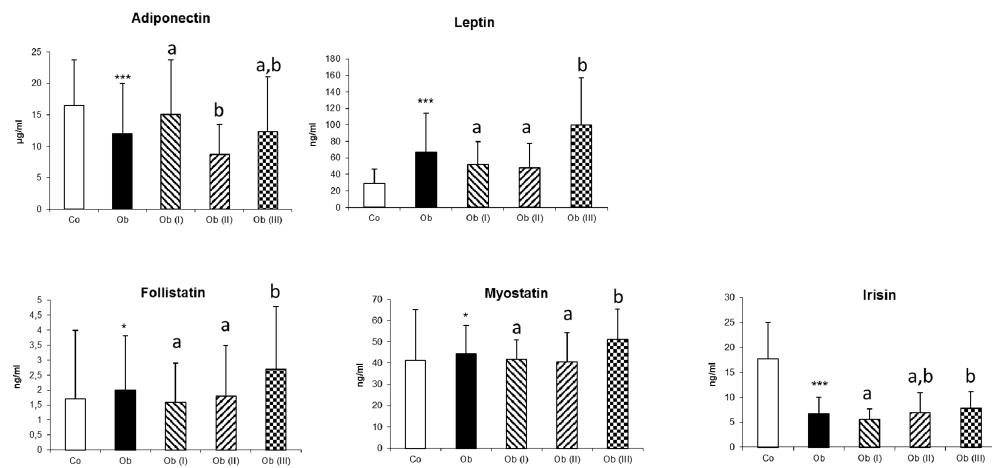
Figure 2. Adipokines and myokines in controls (CO) and in patients (Ob) according to the class of obesity. Data are presented as mean ± standard deviation. Patients with obesity were classified into three subgroups according to the body mass index (BMI) as follows: Class I obesity (Ob I): patients with BMI 30-34.9 kg/m²; Class II obesity (Ob II): patients with BMI 35-39.9 kg/m²; and Class III obesity (Ob III): patients with BMI ≥ 40 kg/m². * indicates a significant difference between controls and patients with obesity for p < 0.05 and *** for p < 0.001. For comparisons between subgroups of patients with obesity according to the BMI, there are no significant difference when two subgroups share the same letter or no letter (a or b) is displayed.